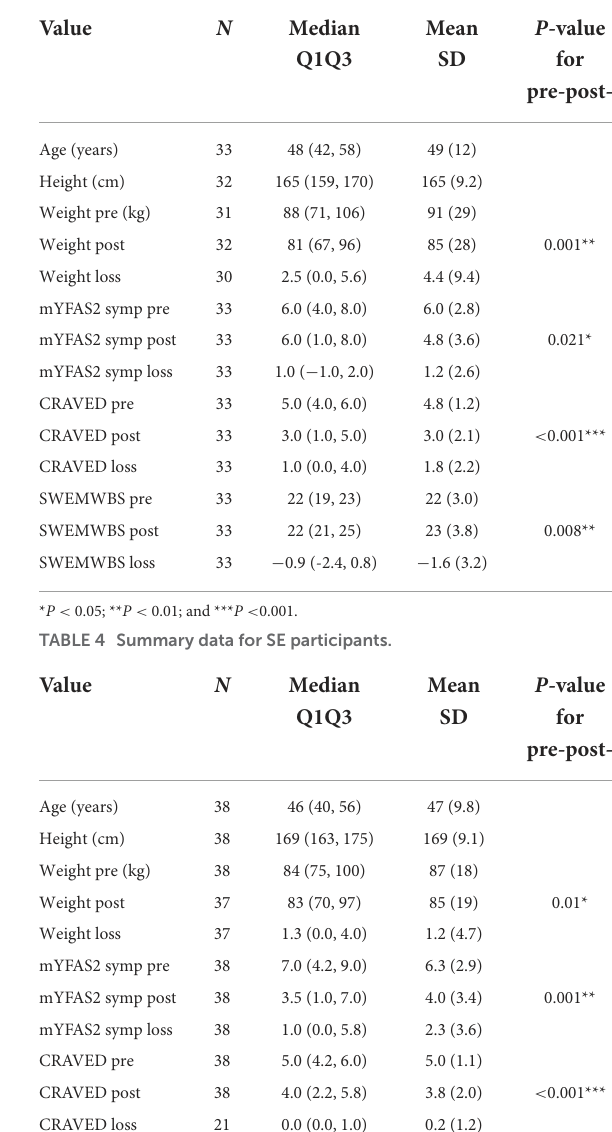
Figures 1–4 show line plots and forest plots for mYFAS2 score, CRAVED score, SWEMWBS score and weight. The line plot shows change over time for each participant across study locations. Improvement (e.g., decreased mYFAS2 score or increased SWEMWBS) is shown as dark green while the opposite change, or no change, is light green. Random effects forest plots calculate the overall change across all three settings. All scores changed significantly from pre- to post- intervention. The mYFAS2 symptom score decreased,